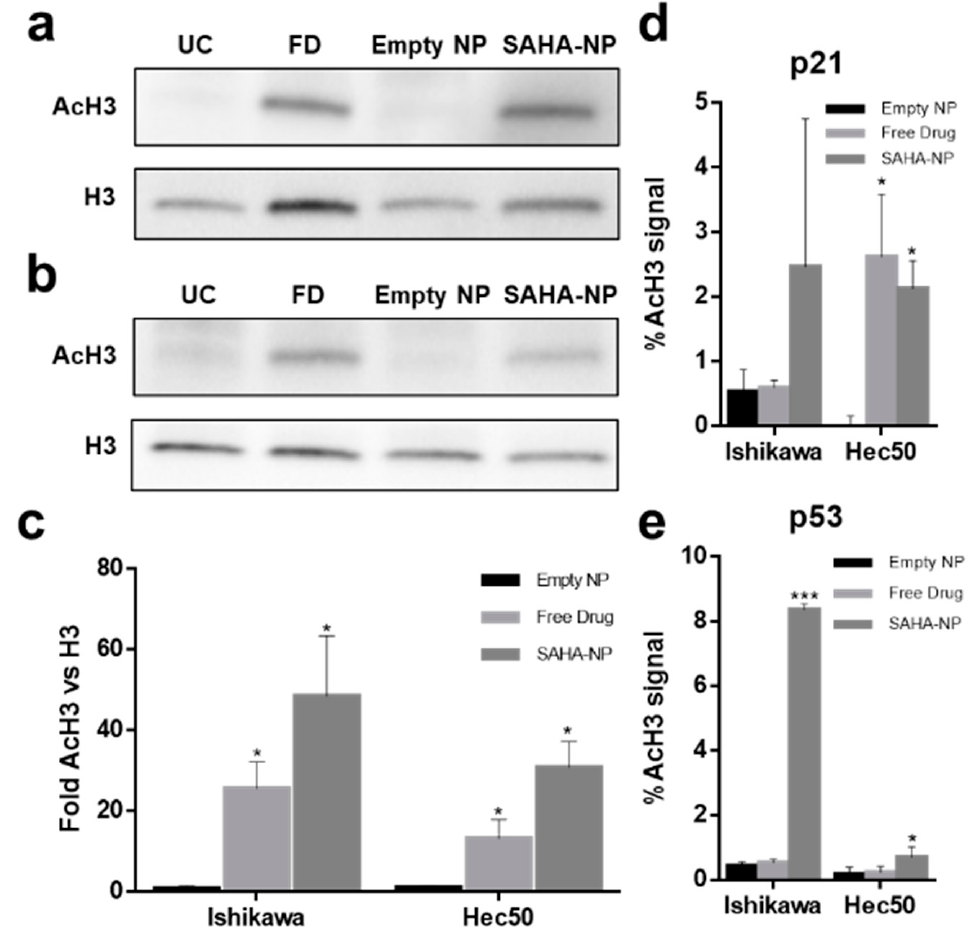
Figure 5. Mechanism of action of SAHA encapsulated and free SAHA drug in endometrial cancer cells. Protein blot analysis (AcH3 and H3) to demonstrating the SAHAs mechanism of action in Ishikawa ( a ) and Hec50 cells ( b ) (original images can be found at Figure S9), and protein density analysis of AcH3 ( c ) following 48 h treatments ( n = 3). Treatments tested; empty nanoparticle (black), free SAHA (light grey) and SAHA-NP (dark grey), all treatments were 2.5 µ M. All data are normalized to the untreated control cells. Effect of SAHA on AcH3 binding to the p21 promoter ( d ) and p53 promoter ( e ) in endometrial cancer cells and promoter methylation. ChIP experiments, SAHA effect on binding of AcH3 antibody to the p21 and to the p53 promoter. Hec50 and Ishikawa cells were treated with empty nanoparticle (black), free SAHA (light grey) and SAHA-NP (dark grey) ( n = 3). Statistical significance is indicated on graphs: p ≤ 0.05 denoted by * and p ≤ 0.001 by ***.